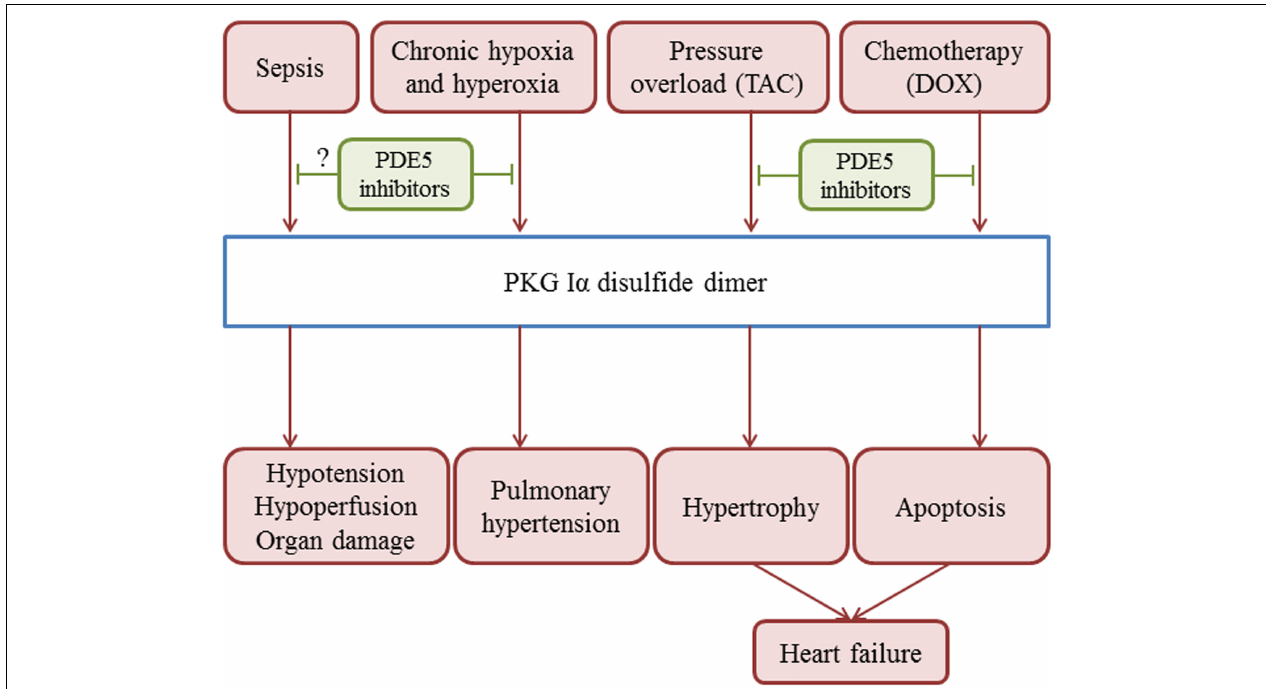
FIGURE 3 | Overview of the roles of PKG I a disulfide dimerisation in the development of pathologies in the cardiovascular